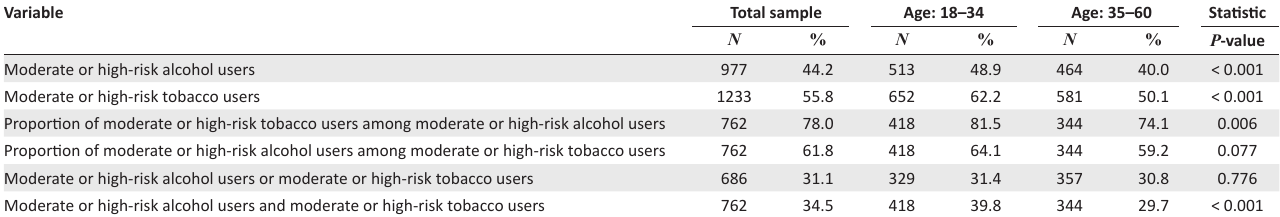
TABLE 2: Alcohol and tobacco user overlap.